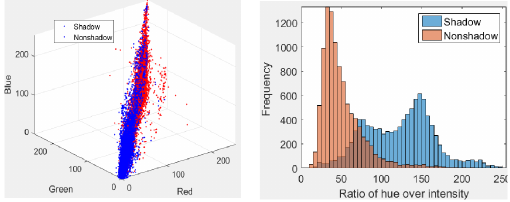
Figure 3. 10,000 training examples are randomly selected for each class and displayed in RGB and Ratio domains in left and right image